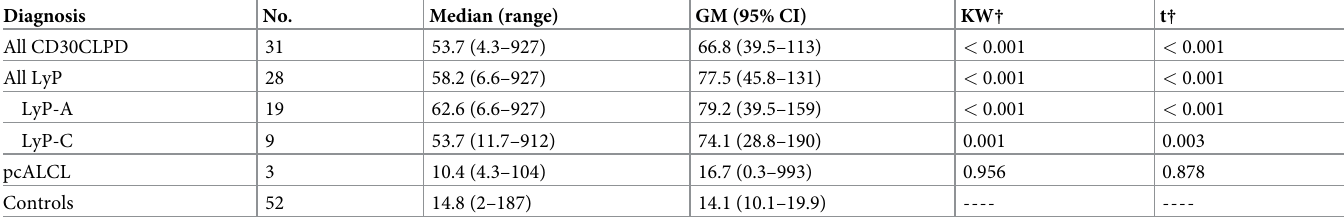
Table 1. Total serum IgE according to diagnostic